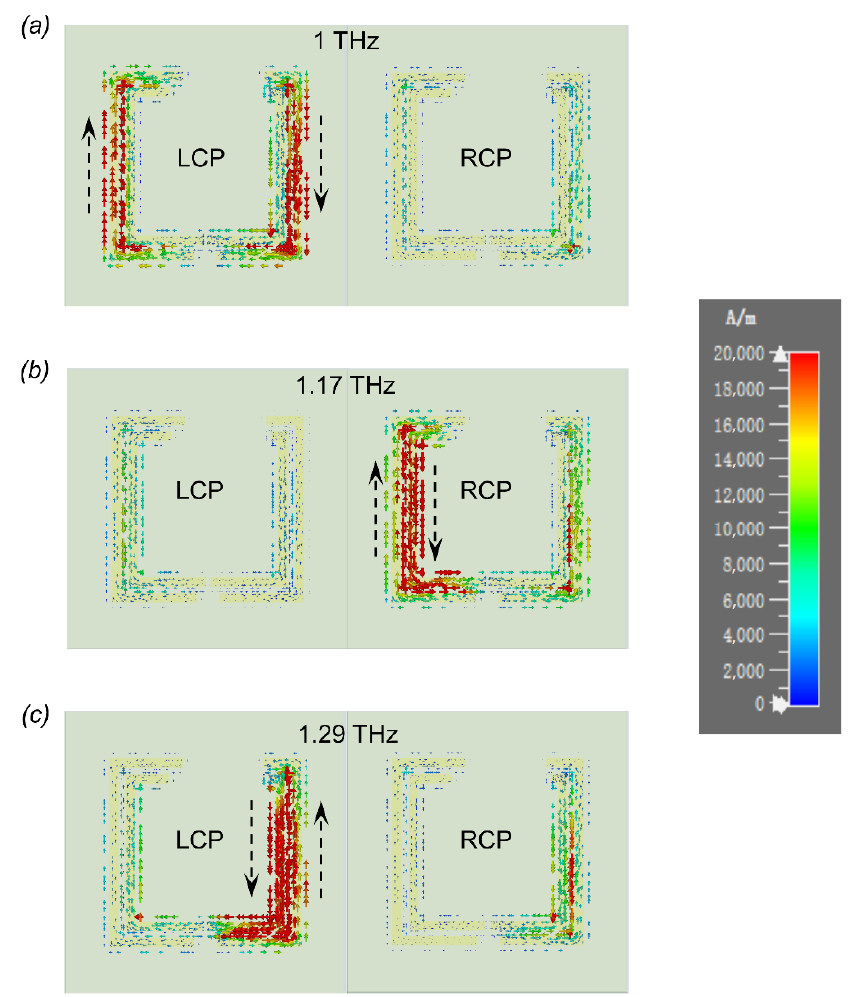
Figure 4. Surface current distributions of the T-SRR under the incidence of CP waves in different spin states. ( a ) T-SRR under the normal incidence of LCP/RCP at 1 THz; ( b ) T-SRR under the normal incidence of LCP/RCP at 1.17 THz; ( c ) T-SRR under the normal incidence of LCP/RCP at 1.29 THz.